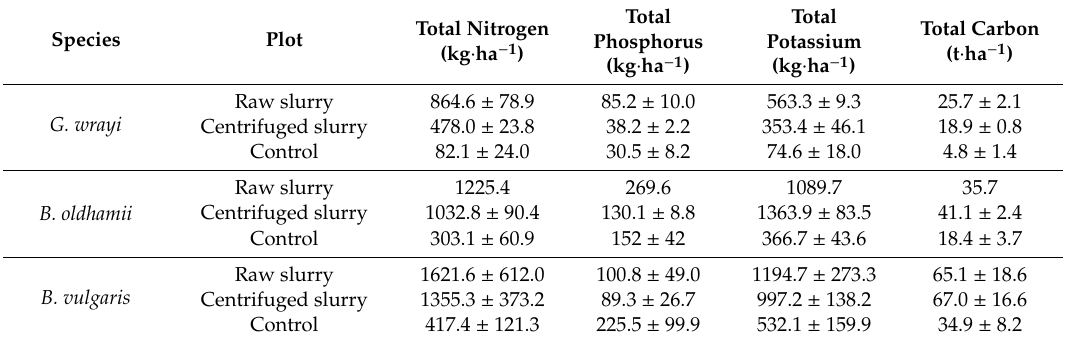
Table 1. Average nutrient content in leaves by treatment (g · kg − 1 dry matter (DM)). Gigantochloa wrayii (GW), Bambusa oldhamii (BO), Bambusa vulgaris (BVV).